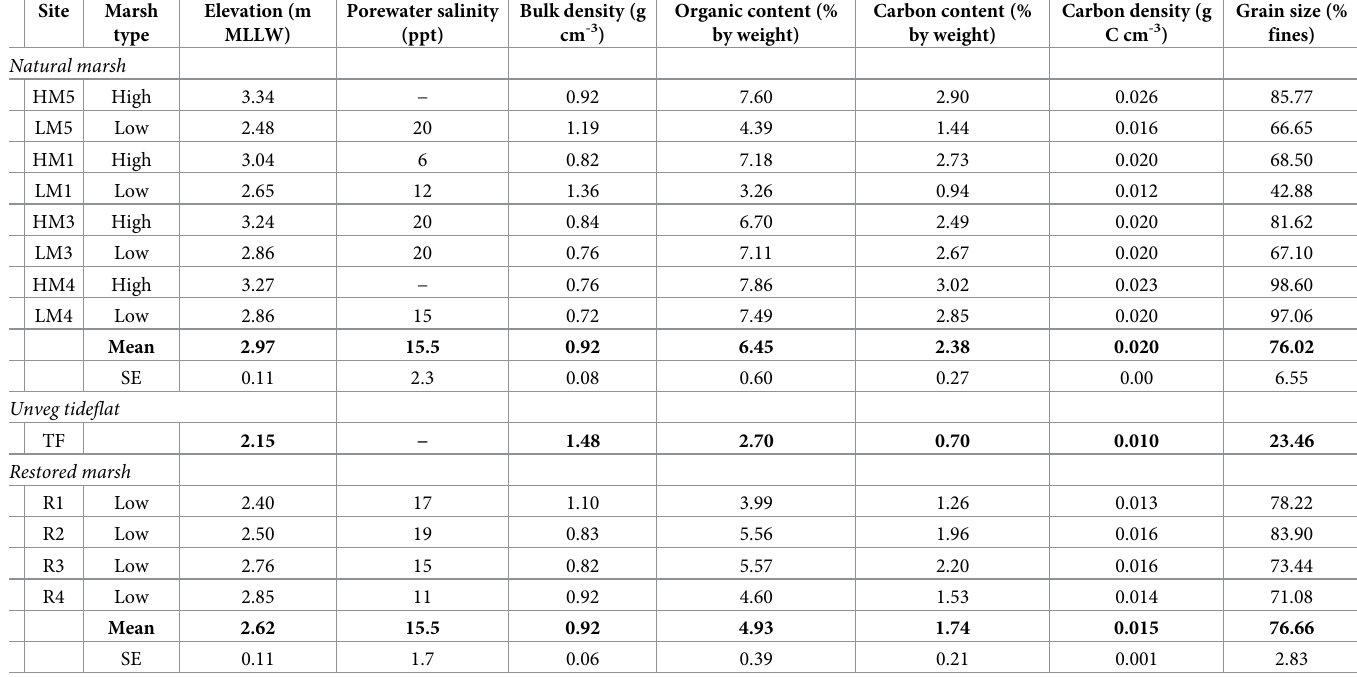
The mean sediment bulk density observed at both natural and restored marsh sites was identi- cal, at 0.92 g cm -3 , lower than the tidal flat bulk density of 1.48 g cm -3 (Table 1). In general however, organic matter content, organic carbon content, and carbon density values were highest at natural marsh sites, intermediate at restored sites, and lowest at the tidal flat site. Organic matter content averaged 6.45% at natural marsh sites, 4.93% at restored sites, and Table 1. Site elevation, marsh type, porewater salinity, and sediment characteristics. Sediment characteristics (bulk density, organic content, carbon content, carbon density, and grain size) are reported as the average value across the top 30 cm. Elevation is given relative to mean lower low water (MLLW). Site Marsh